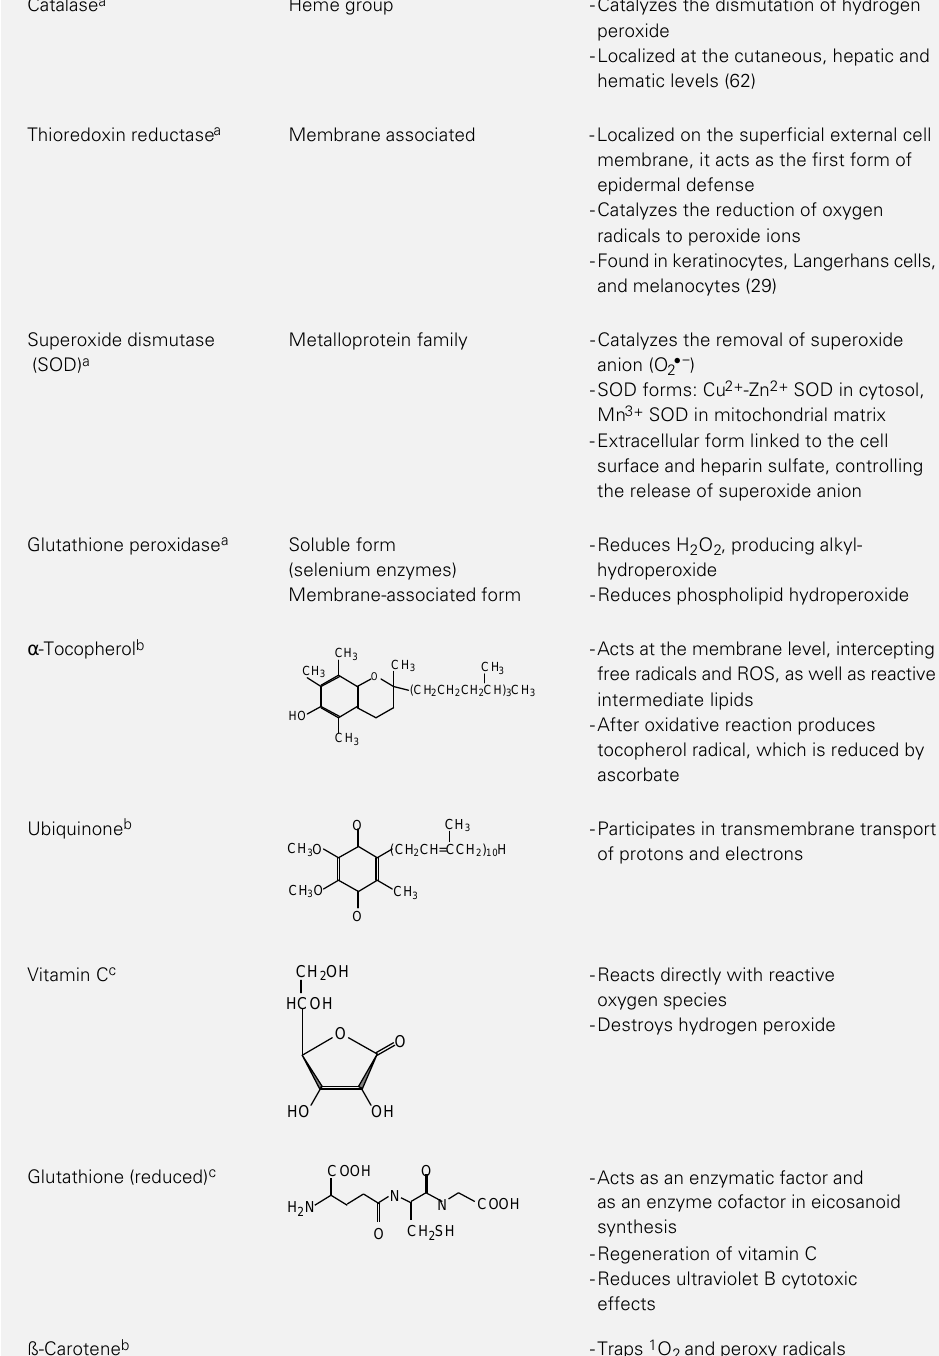
Table 4 - Systemic antioxidant